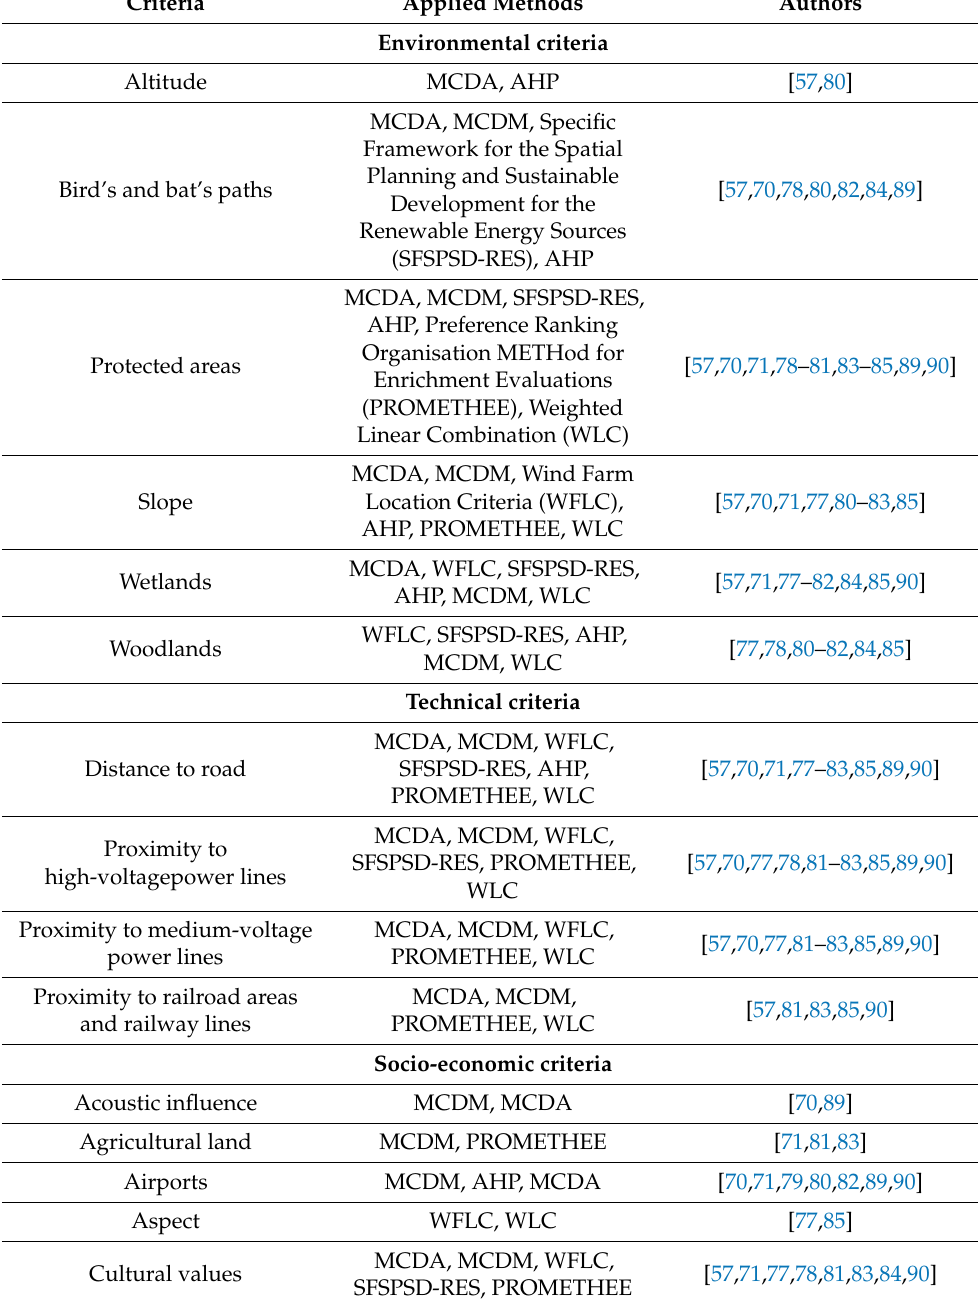
Table 3. Classification of wind farm location criteria according to applied methods by